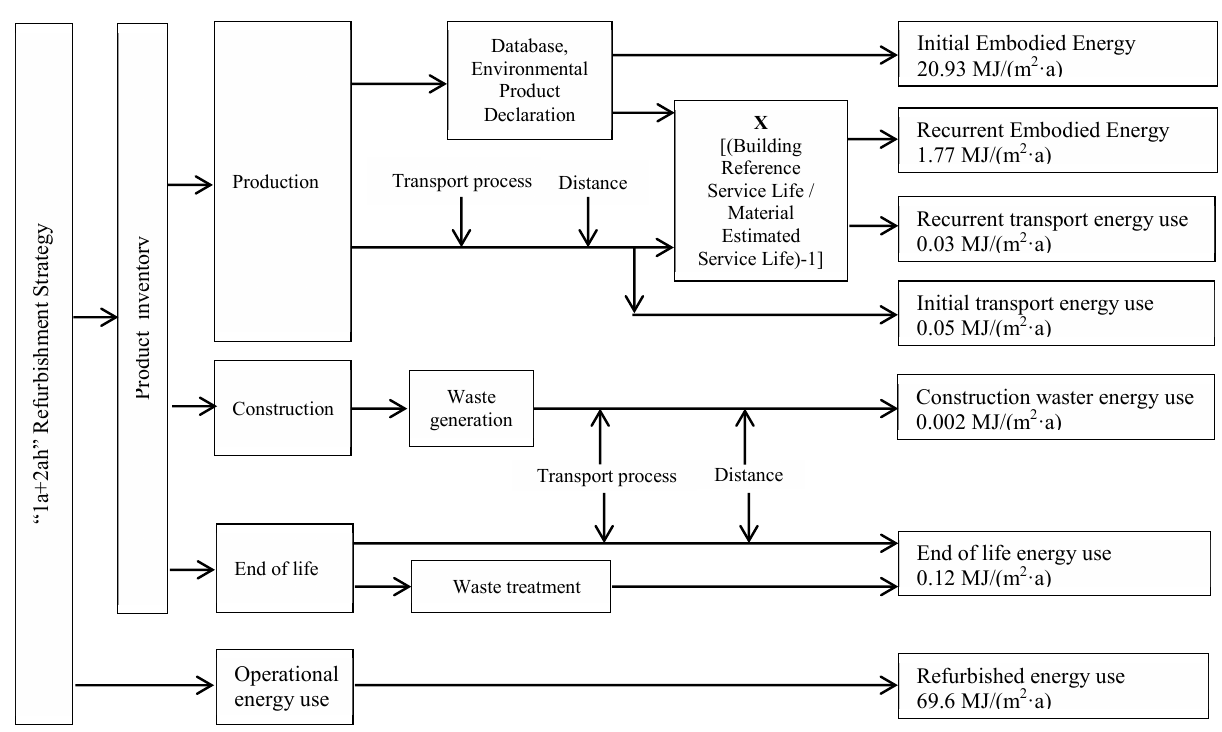
Figure 3. Scheme of inputs and Non Renewable Primary Energy (NRPE) use of each life cycle phase of the 1a + 2ah energy refurbishment